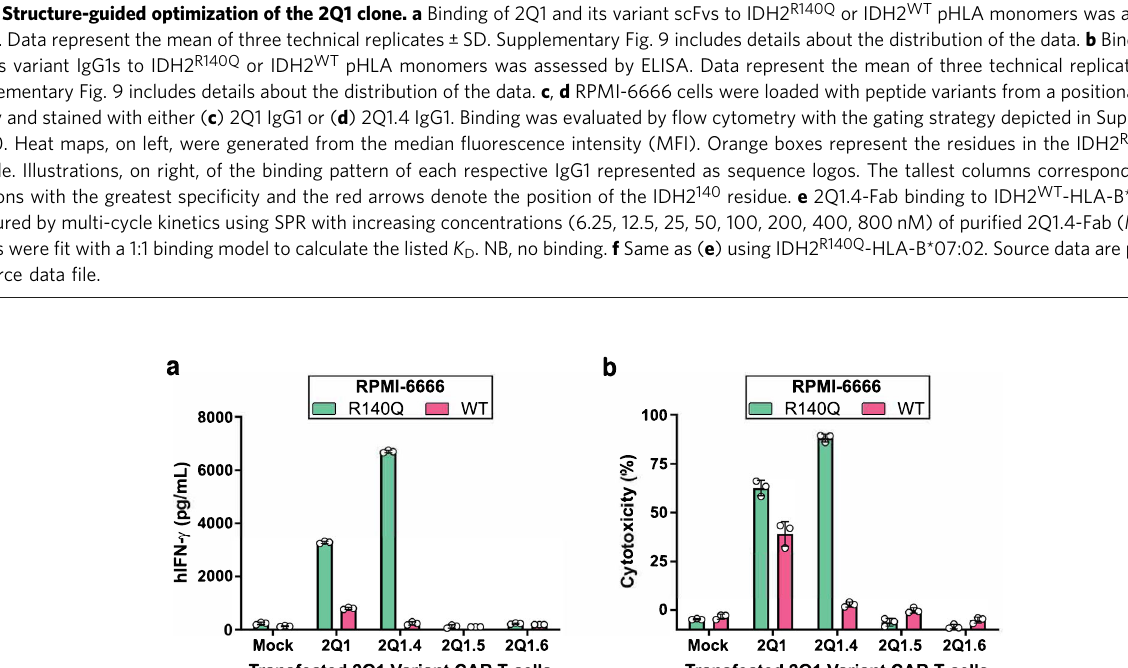
Fig. 6 Evaluation of 2Q1.4 CAR T-cell activity. 2Q1 variant CAR T cells were co-incubated with RPMI-6666 cells pulsed with either IDH2 R140Q or IDH2 WT peptides at an effector-to-target (E:T) ratio of 1:1. a T-cell activation, as assessed by IFN- γ release, was measured by ELISA. Bars represent the mean of three technical replicates ± SD, while open circles represent the individual data points. b Cytotoxicity was measured by Steady-Glo. Bars represent the mean of three technical replicates ± SD, while open circles represent the individual data points. Source data are provided as a Source data fi